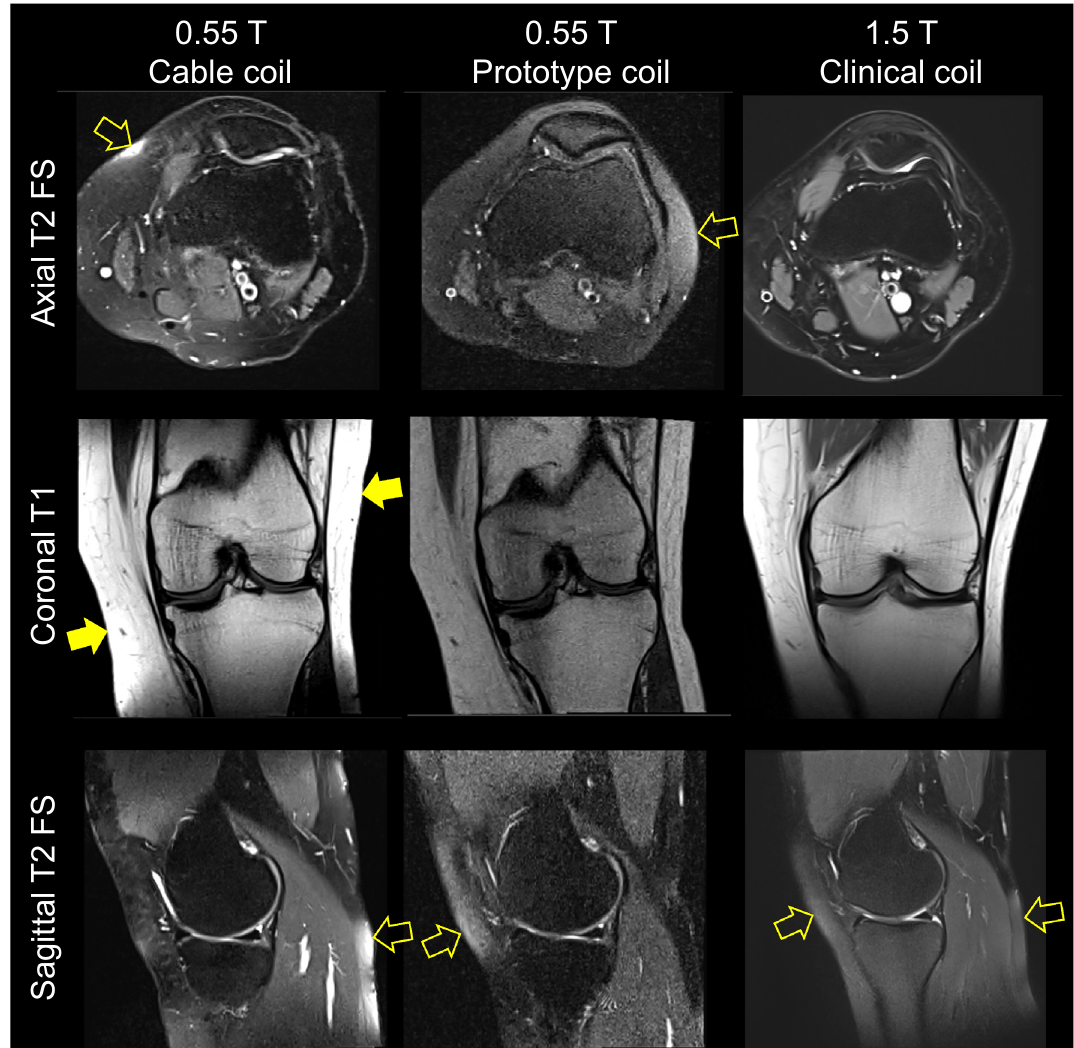
Figure 15. Turbo spin echo MR images from a 28-year-old woman acquired with the 0.55 T 6-channel cable coil (left column), 0.55 T prototype coil (middle column), and 1.5 T clinical coil (right column). The cable coil images have peripheral signal saturation (solid arrows). Images acquired with all coils had heterogeneous fat suppression (hollow